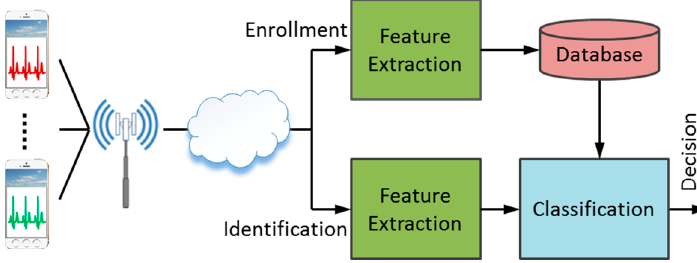
Figure 2. Biometric patient verification system using mobile ECG.